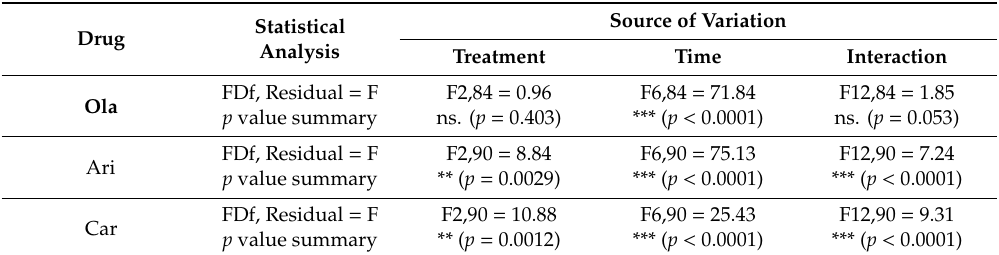
Figure 2. The body weight change (gain / loss) during the drug administration period expressed as percent relative to the initial weight. ( A ) Groups treated with Ola and Ctr. ( B ) Groups treated with Ari and Ctr. ( C ) Groups treated with Car and Ctr. Values displayed are means with SEM. Statistically significant di ff erences (compared to the Ctr of the same week) are noted with * ( p < 0.05), ** ( p < 0.01), *** ( p < 0.001). Significant di ff erences between treatment regimens with two doses of the same drug are noted with + ( p < 0.05), ++ ( p < 0.01), +++ ( p < 0.001). Table 2. Results of two-way ANOVA analysis of the body weight change expressed as a percent of initial body